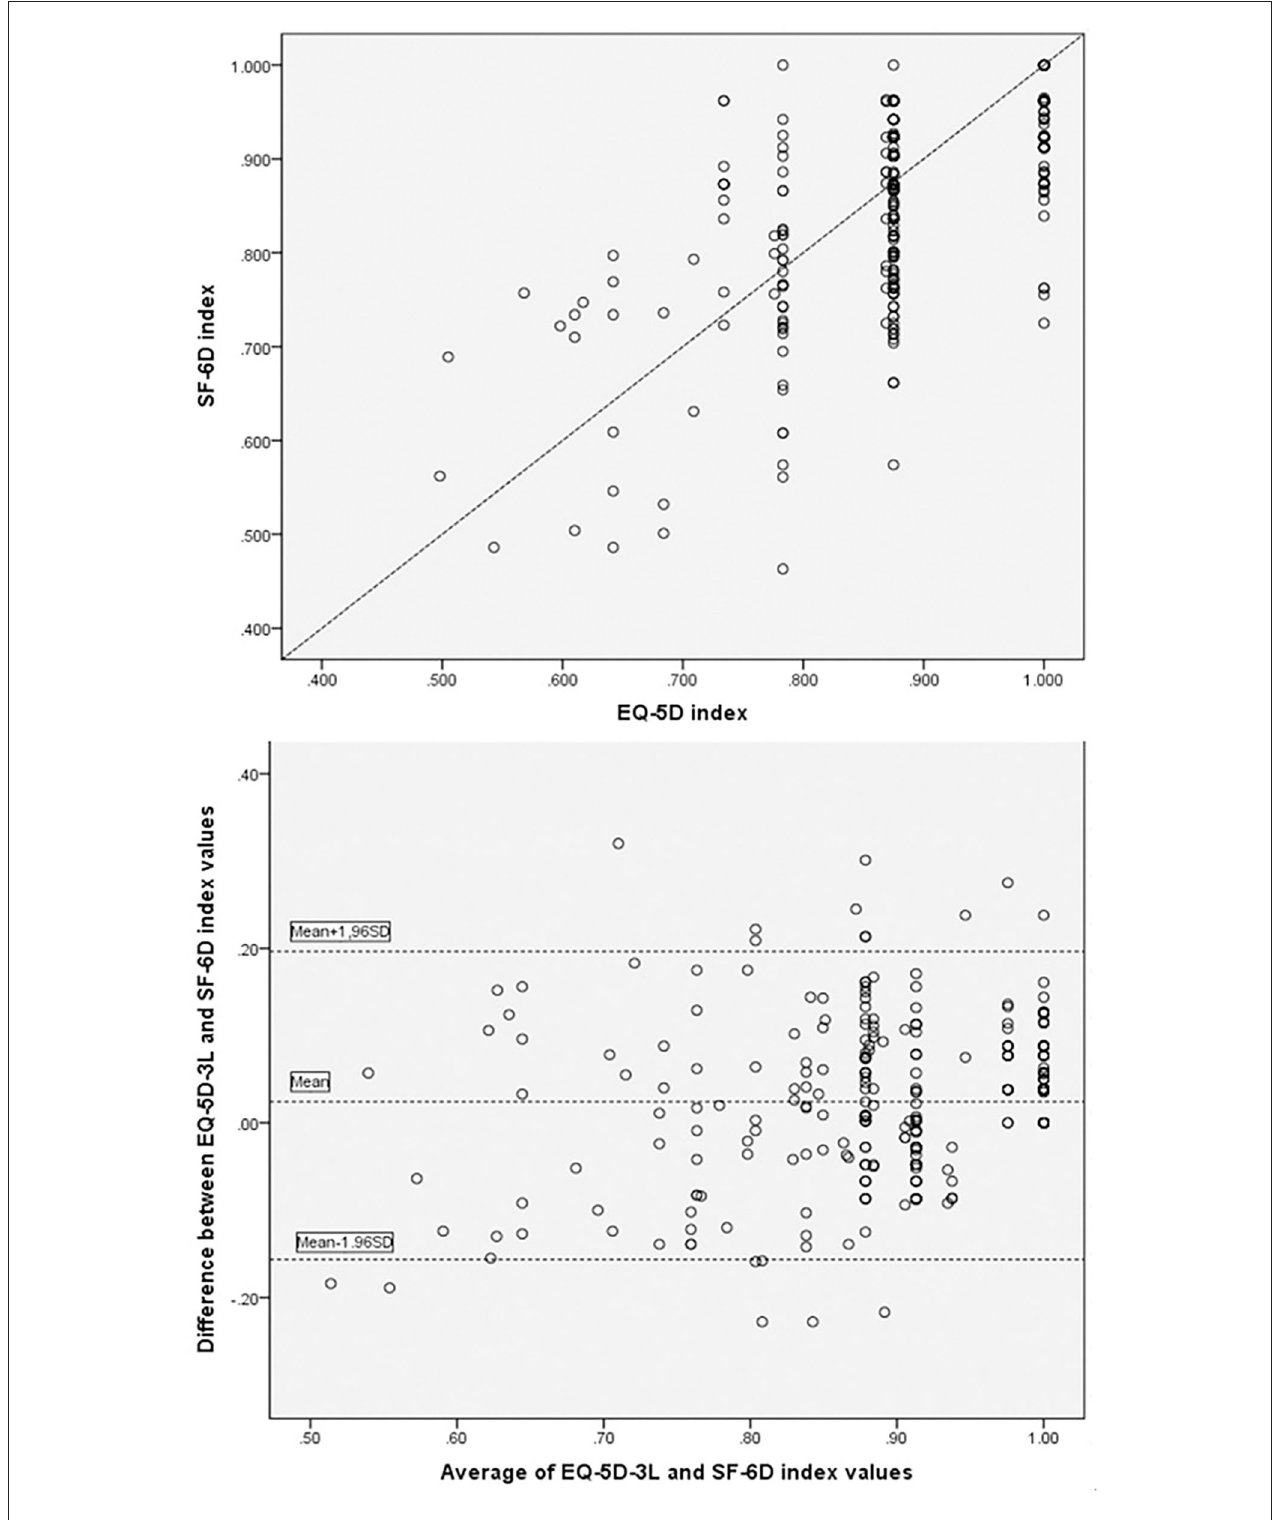
FIGURE 3 | Paired utility scores for the entire population and Bland-Altman plot.